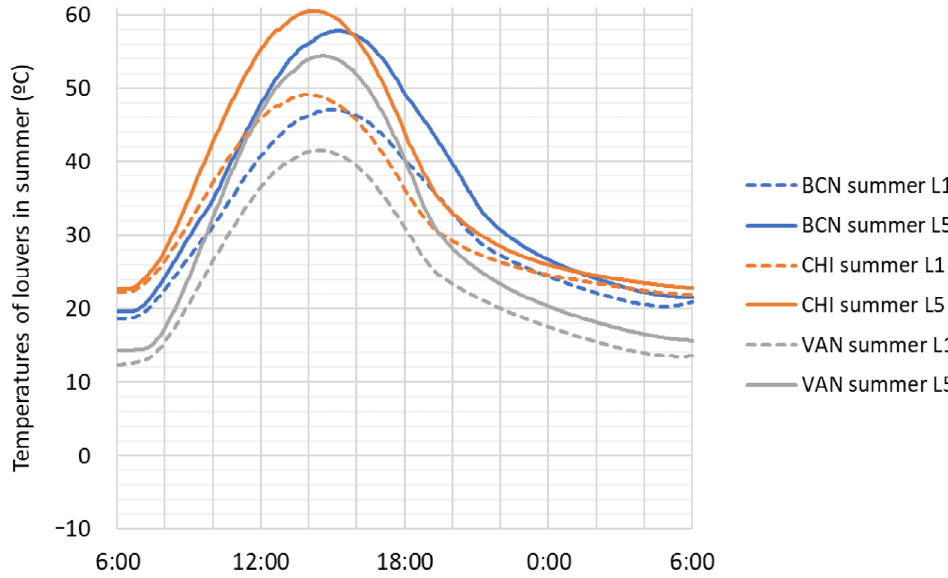
Figure 15. Temperature of the louvres on each summer day calculated.